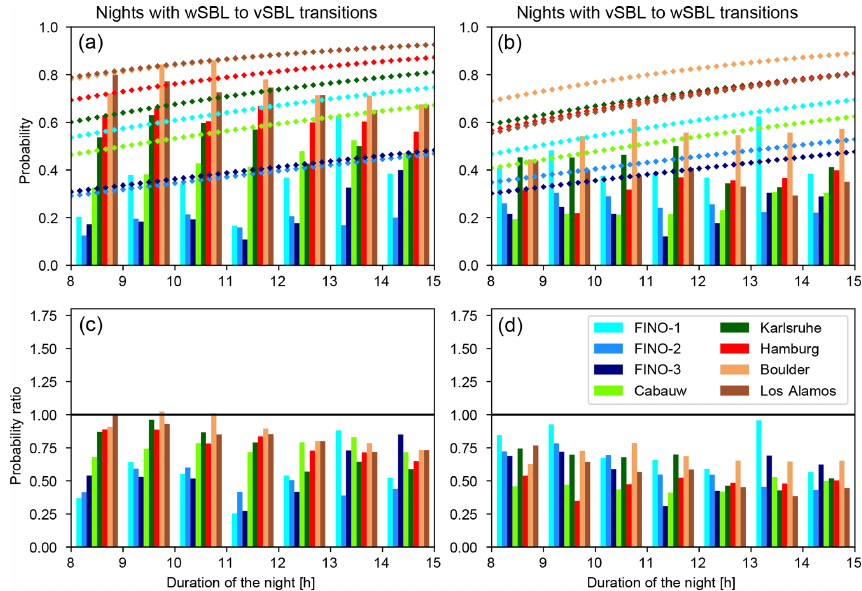
Figure 2. As in Fig. 1 but for the occurrence probabilities of at least one wSBL to vSBL (a, c) or vSBL and wSBL (b, d) transition within a